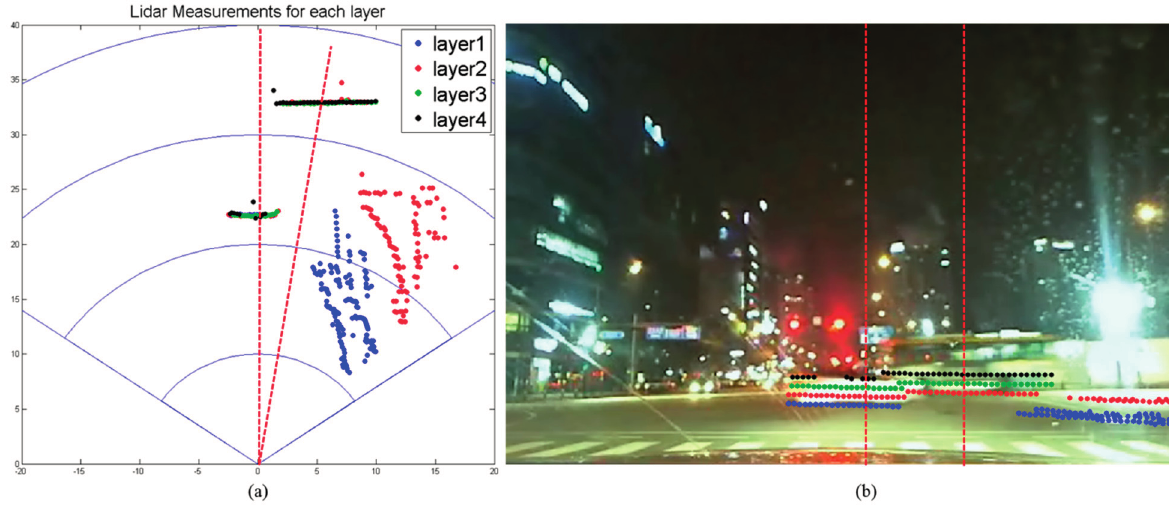
Figure 4. Multi-layer laser scanner ( a ) scan data and ( b ) corresponding